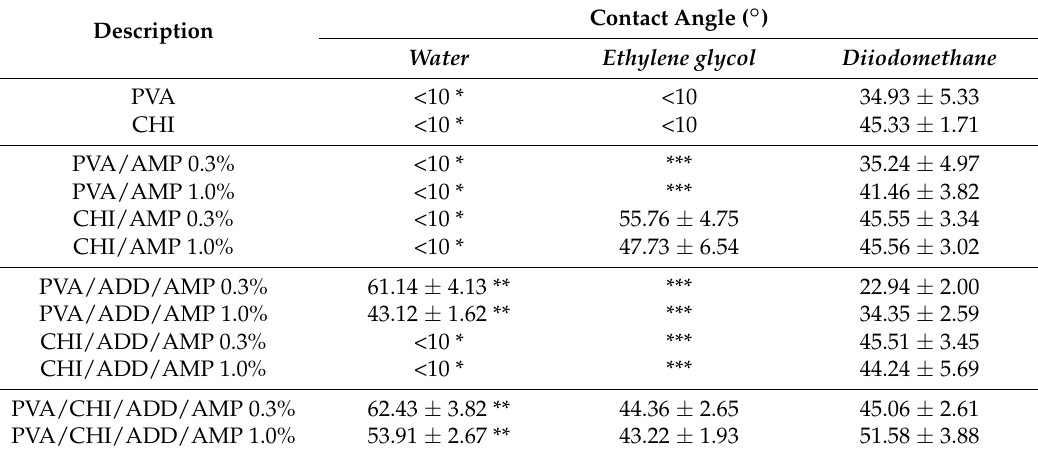
Table 1. Contact angle values for the prepared materials.